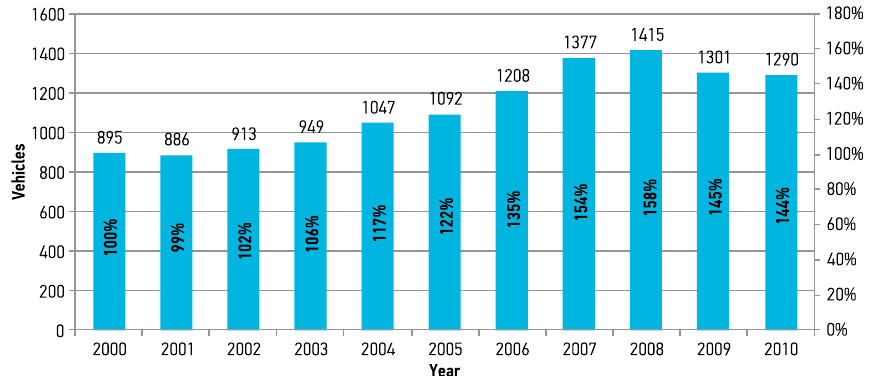
Fig. 2. Change in traffic intensity on roads of national significance in 2000–2010